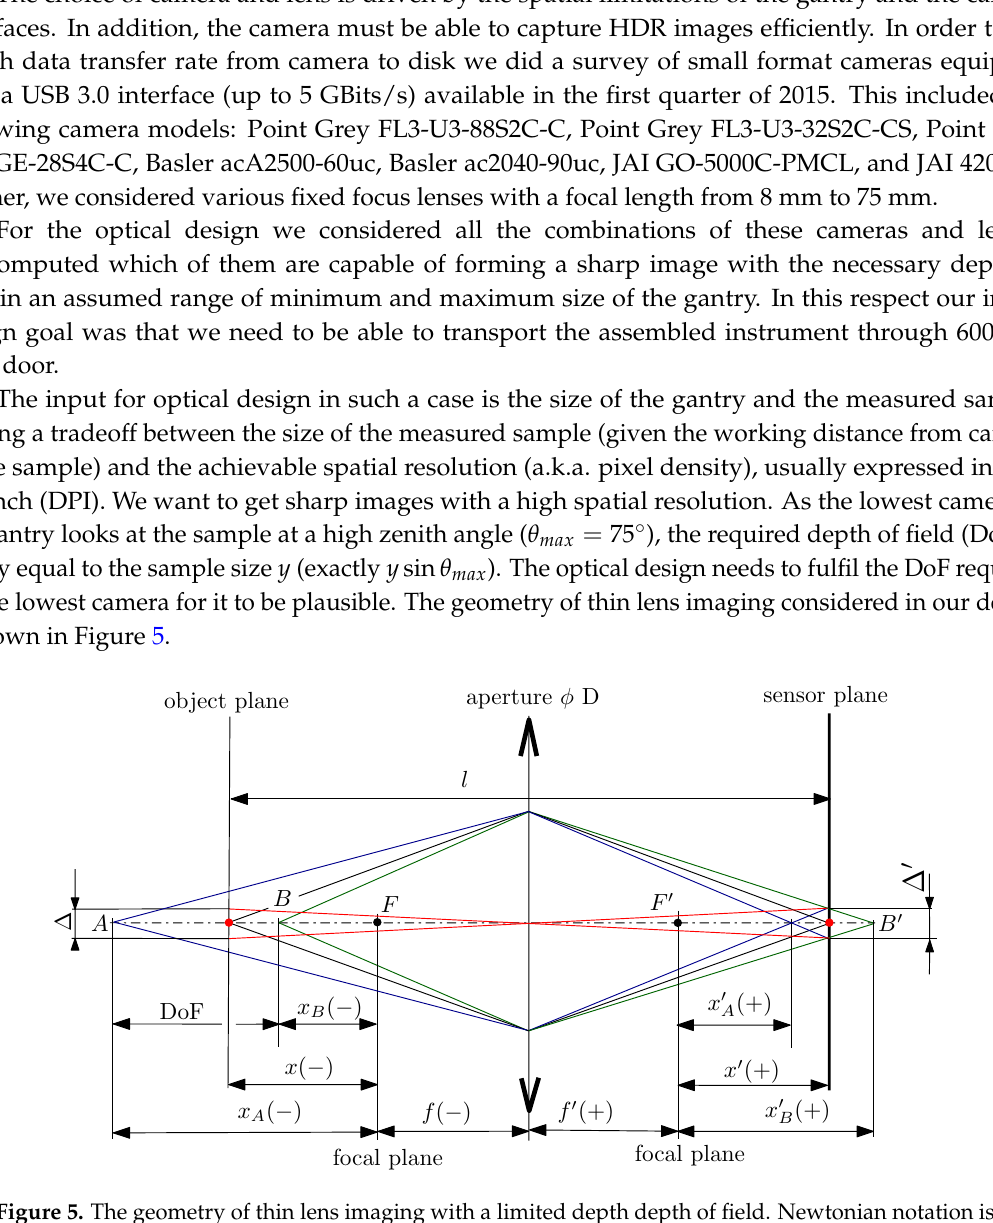
Figure 5. The geometry of thin lens imaging with a limited depth depth of field. Newtonian notation is used, i.e., object and image distances are measured from focal points. x ( x (cid:48) )—object (image) distance; A —farthest point in focus; B —nearest point in focus; ∆ (cid:48) —pixel size; ∆ —size of pixel projected on the object; l —object to image distance; DoF—depth of field; f ( f (cid:48) )—focal length in object (image)